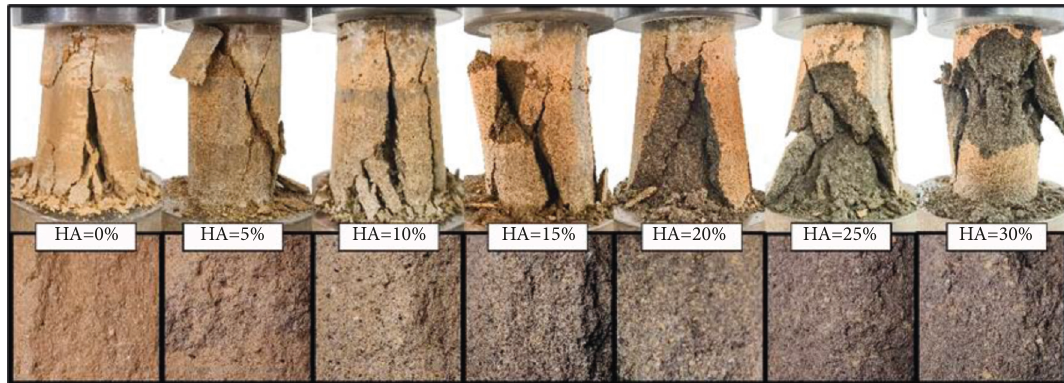
Figure 4: Cement-soil failure form and failure surface.